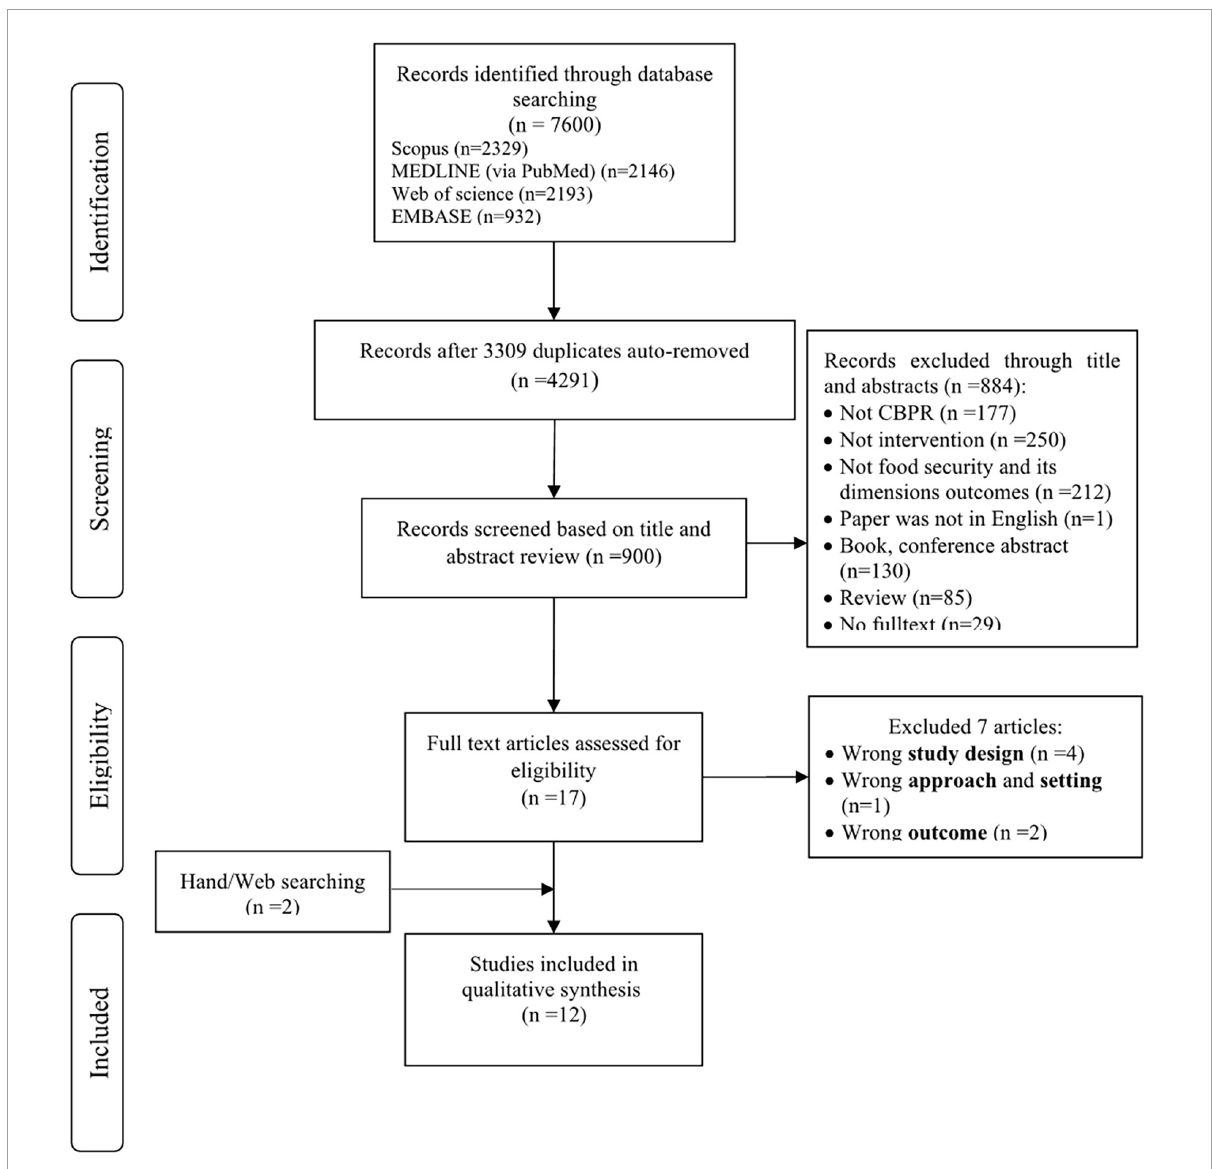
FIGURE1 PRISMA flow diagram of the included studies. RCT, randomized control